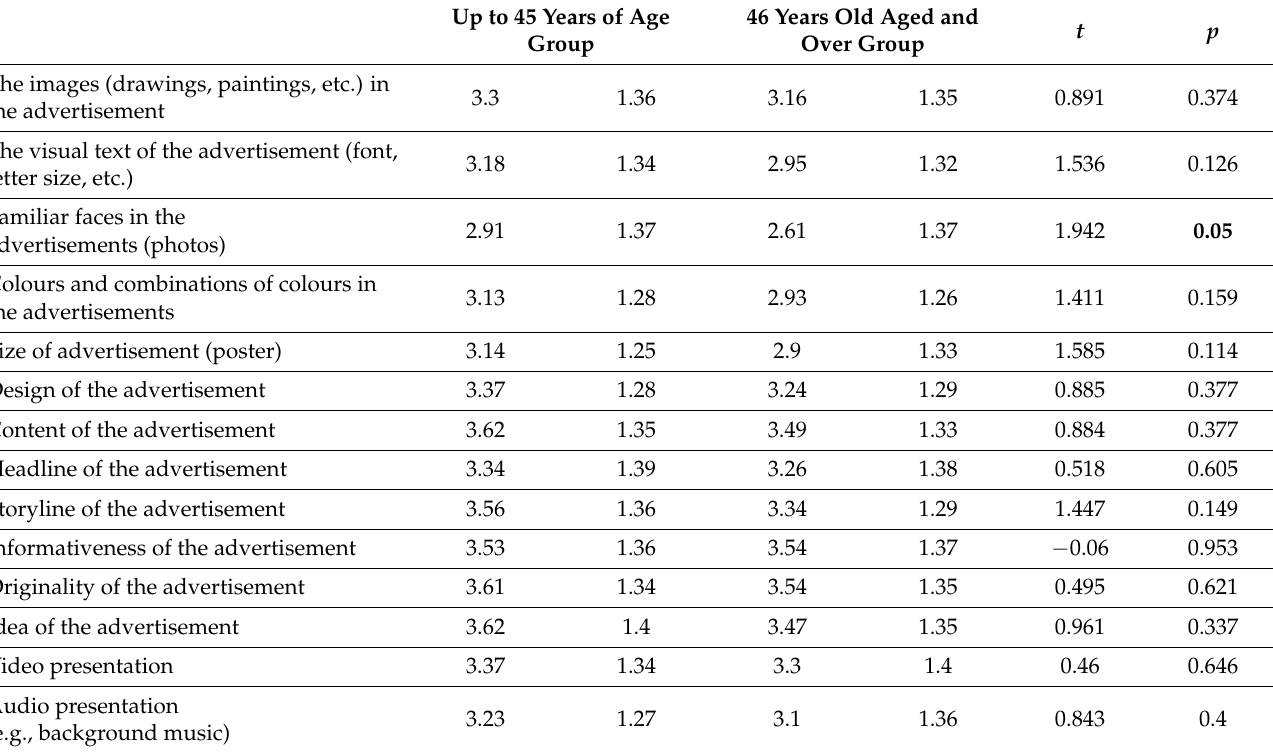
Table 6. Evaluation of advertising elements promoting sustainable mobility and multimodality in different age groups ( t -test for independent samples). Up to 45 Years of Age 46 Years Old Aged and t Group Over Group